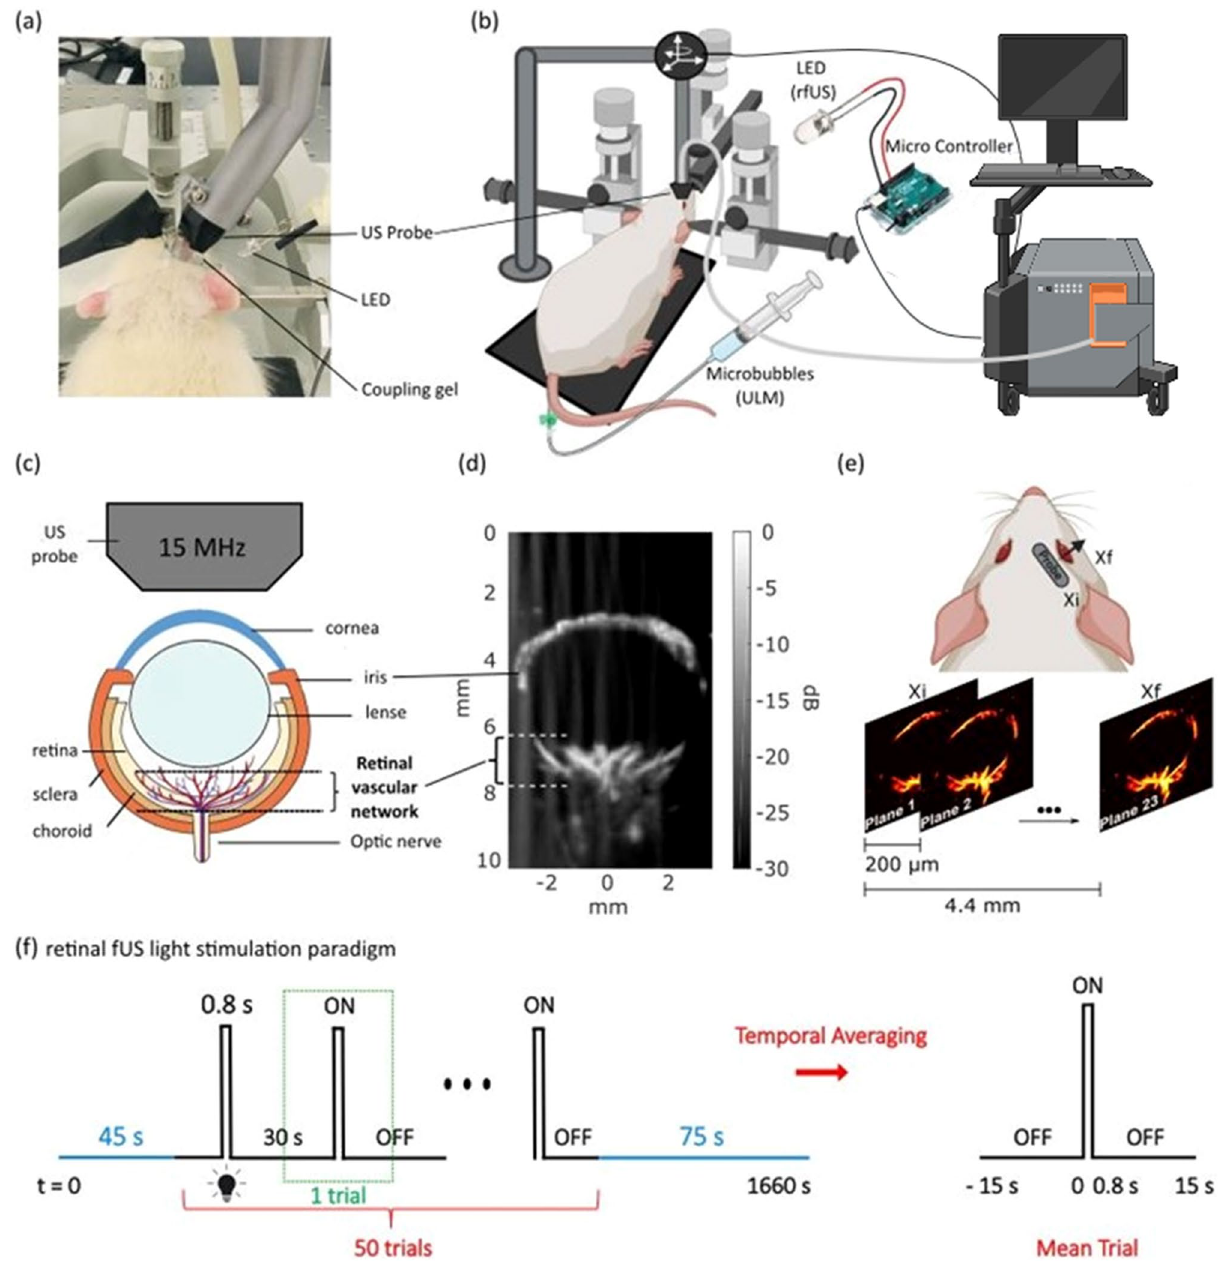
Figure 1. Ultrasound Localization Microscopy and fUS Imaging Set Up. ( a ) Picture of the experimental setup. The animal is anesthetized and placed in a stereotaxic frame for the correct positioning of the US probe. After eye drop and mydriatic instillation, the eye is covered with ophthalmic coupling gel. The probe is tilted to image the plane shown in ( d ). ( b ) Scheme of the entire setup. The probe is connected to a functional ultrasound scanner. The microbubbles solution is a contrast agent administered intravenously via one of the rat tail lateral veins for ULM. The LED delivers light flashes for rfUS imaging and is triggered by the scanner through a microcontroller (Arduino) for precise timings. ( c ) Scheme of the rat eye, its principal structures, and the imaging field comprising the retinal vascular network. ( d ) Doppler image of a rat eye. The retinal vascular network is visible. ( e ) ULM scanning details. The scan starts at the initial position x i in 200 µm steps along the mediolateral axis to the final position x f . ( f ) Retinal fUS imaging stimulation design. The acquisition consists of a baseline recording of 45 s followed by 50 consecutive trials and terminated by a recovery period of 75 s, during which the RBV is continuously recorded. One trial consists of 15 s OFF, followed by a short light flash of 0.8 s ON and another 15 s OFF. One acquisition lasts 28 min. The mean trial is obtained via temporal averaging of the successive single trials. Figure created with